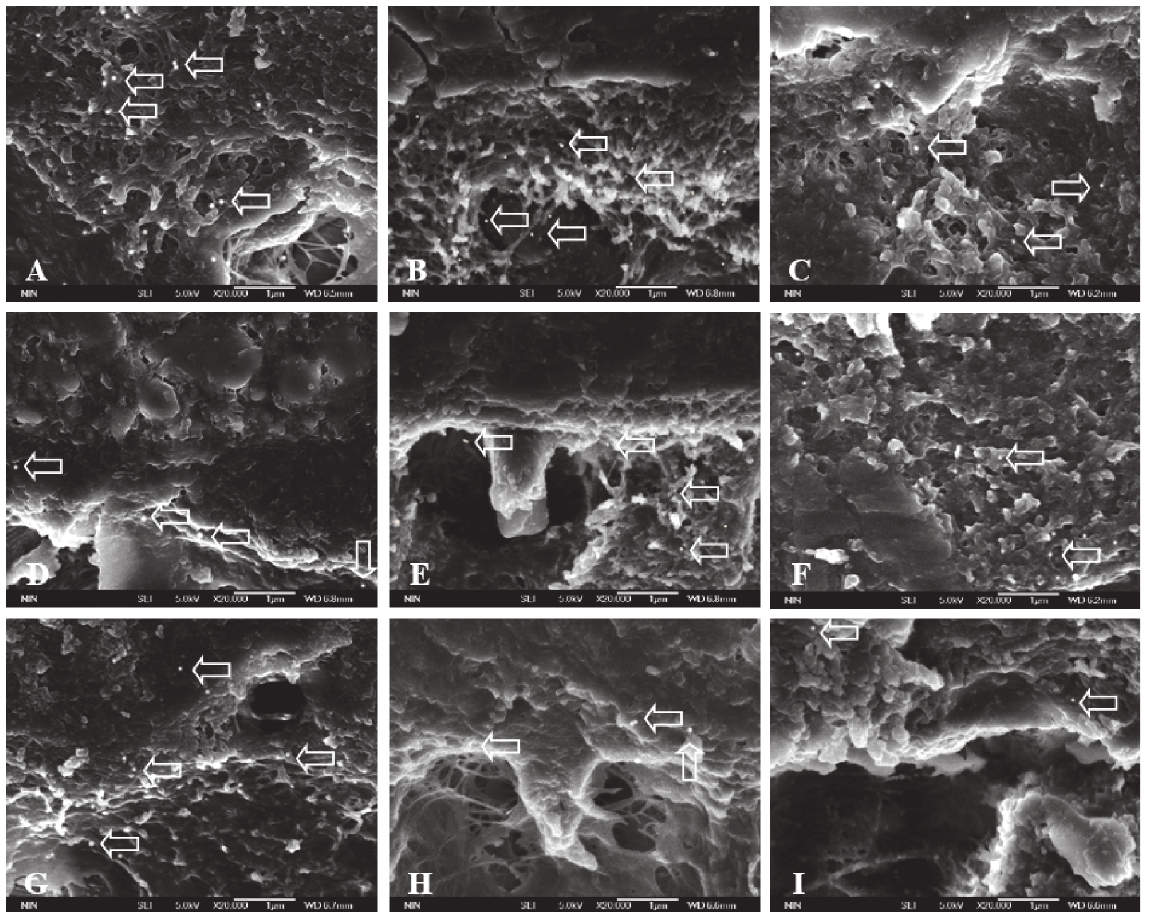
Fig 3. FEISEM micrograph of collagen with immunohistochemistry. (×20 000). A, B, C stand for dentin-SB interface without aging, aged for 1 m and aged for 4 m respectively. D, E, F stand for dentin-SEB interface without aging, aged for 1 m and aged for 4 m respectively. G, H, I stand for dentin-SEB interface without aging, aged for 1 m and aged for 4 m respectively. Arrows stand for collagen fibrils labeling. There are intense collagen fibrils labeling throughout the hybrid layer (Fig. 3A). Fewer labeling can be found throughout the hybrid layer (Fig. 3B). The labeling decreases significantly (Fig. 3C). Fewer positive labeling with uniform distribution are observed (Fig. 3D). Weak labeling can be observed (Fig. 3E). There are weaker gold labeling (Fig. 3F). There are intense uniform distribution of colloidal gold particles through hybrid layer (Fig. 3G). There are the resin tags permeating into the collagen fibrils network with a small quantity of labeling localized around it (Fig. 3H). Scarce labeling is present (Fig.